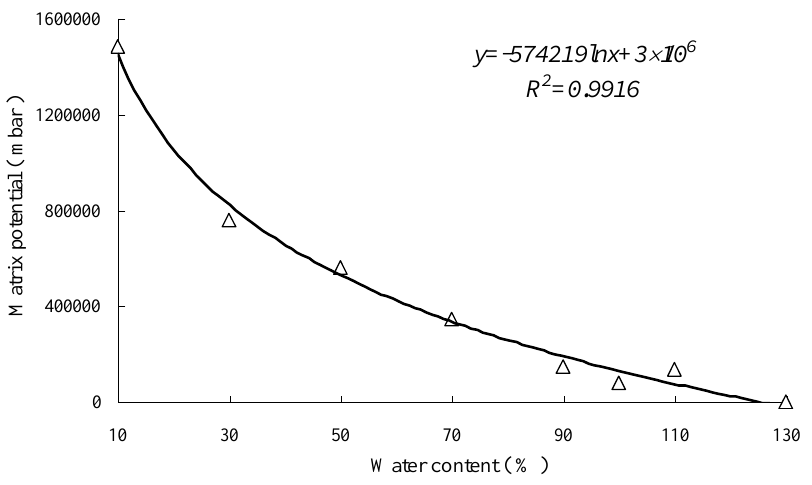
Figure 2. Standard curve for the relationship between matrix potential and water content in silica gel.